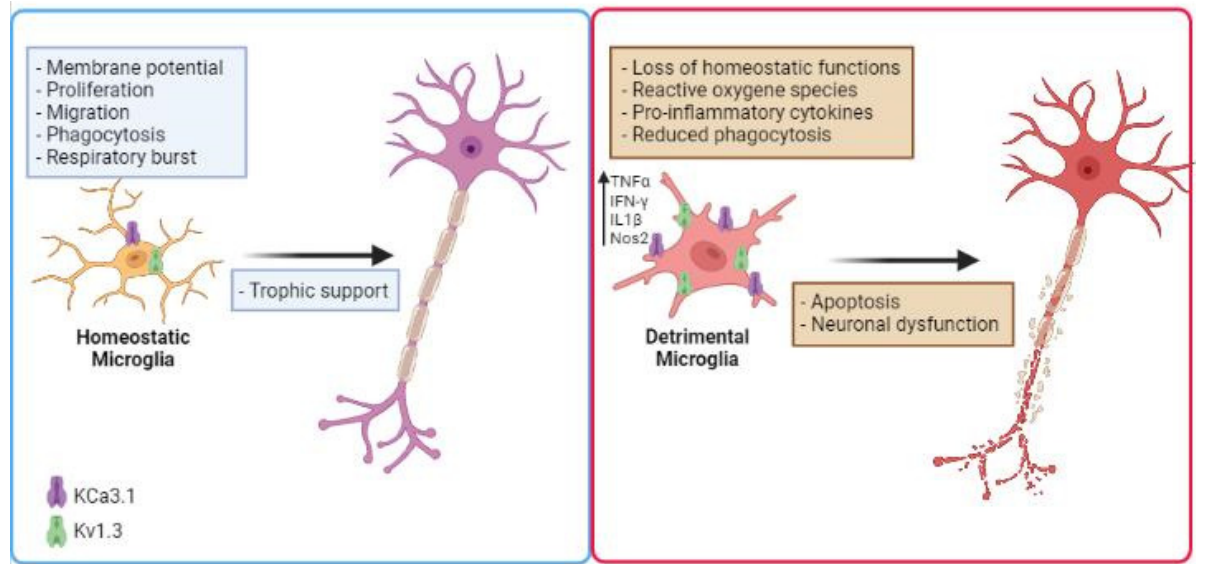
Figure 1. Schematic illustration describing the role of microglial K + channels in NDD. Microglial cells increase the expression/activity of K v 1.3 and K Ca 3.1 in several neurodegenerative diseases, losing their homeostatic functions. This is associated with the release of inflammatory cytokines such as IFN- γ and TNF- α , production of noxious substances (ROS), reduced phagocytic activity, which are involved in inflammation-mediated neurotoxicity. Created in BioRender.com.